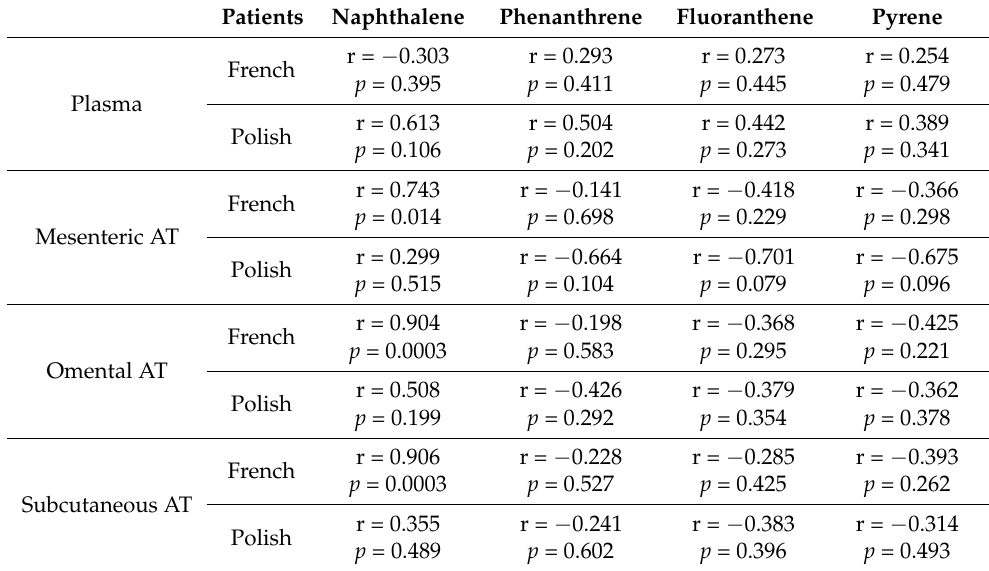
Table 4. Correlation between BMI and PAH concentration in ATs (ng/g) or blood plasma (ng/mL) in (A) French ( n = 10) and Polish ( n = 10) patients.